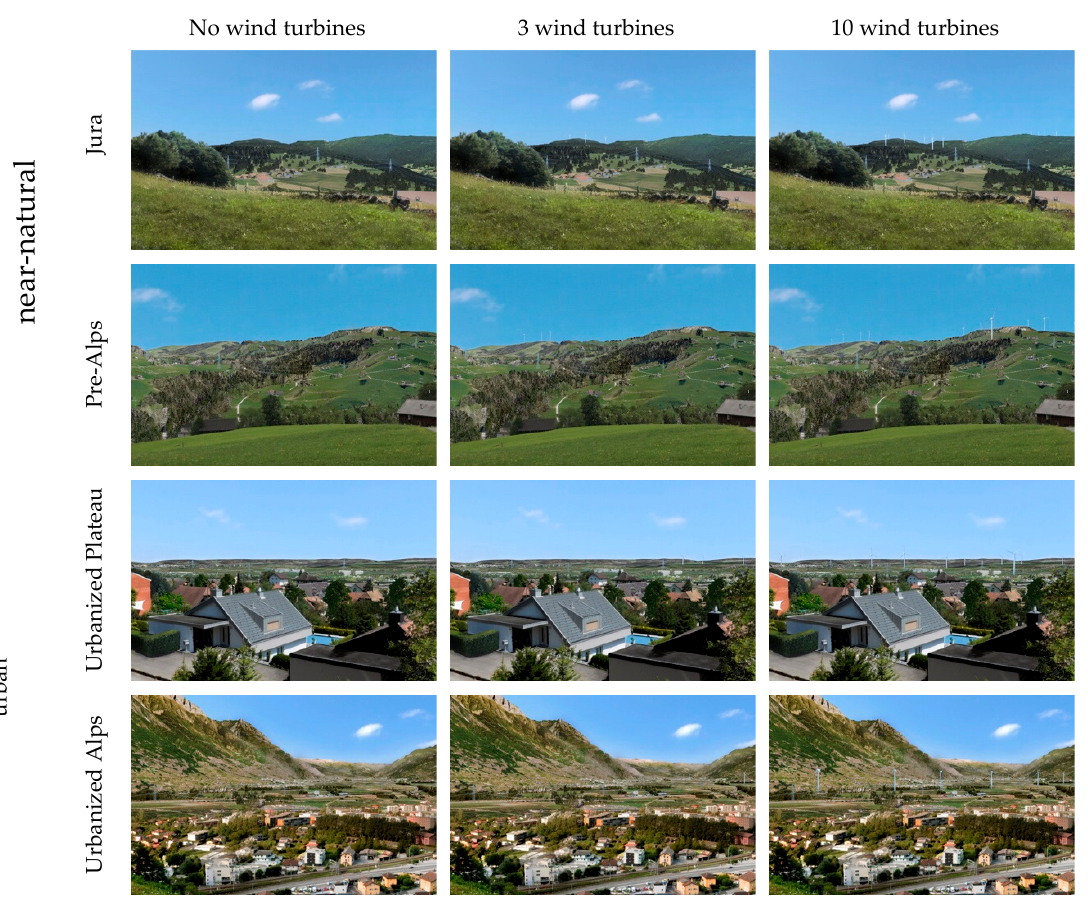
Figure 1. Renderings of the four different landscapes with power lines and different numbers of wind turbines employed for the experiment. (3D visualization: Reto Spielhofer, Ulrike Wissen Hayek and Kilian Müller).